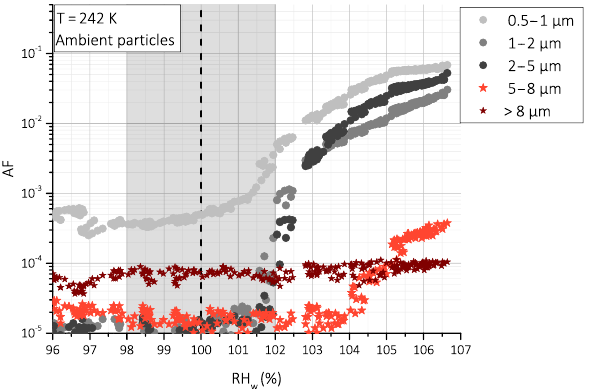
Figure 4. Water droplet activation fraction and subsequent growth as function of RH w at 242K for ambient polydisperse particles sam- pled at the JFJ, shown for all size channels in the OPC. Vertical dashed line represents expected onset for cloud droplet formation; grey area refers to the calculated variation and uncertainty of RH in the aerosol